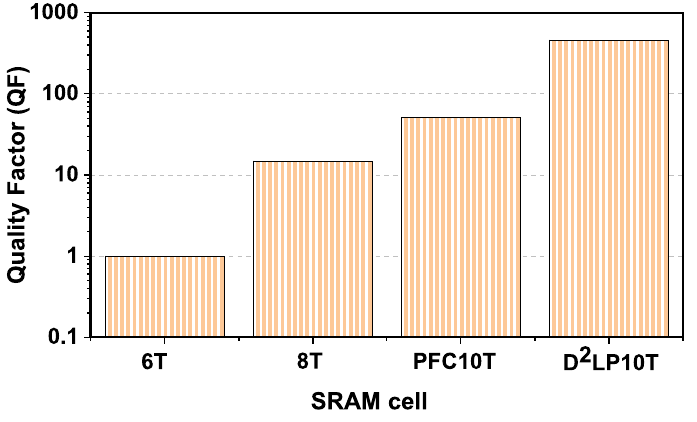
Figure 15. Normalized value of quality factor for different SRAM